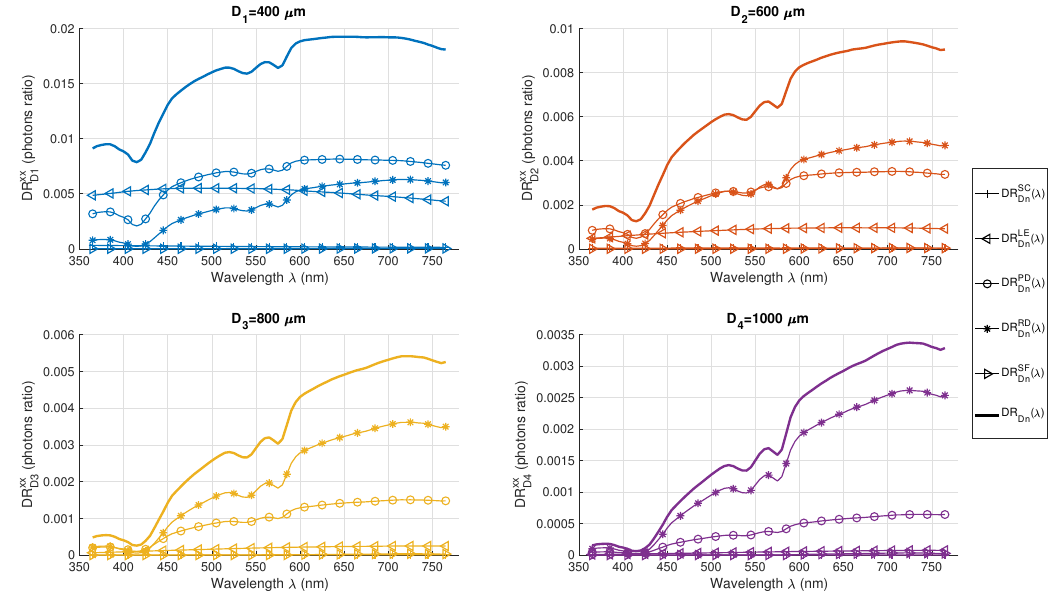
Figure 11. DR signal decomposition according to Equation (4) for the distances D 1 – D 4 in the healthy skin model with intermediate thicknesses of SC and LE layers, mean dermal blood content and phototype I. The correspondence between symbols and layers considered is indicated in the legend on the